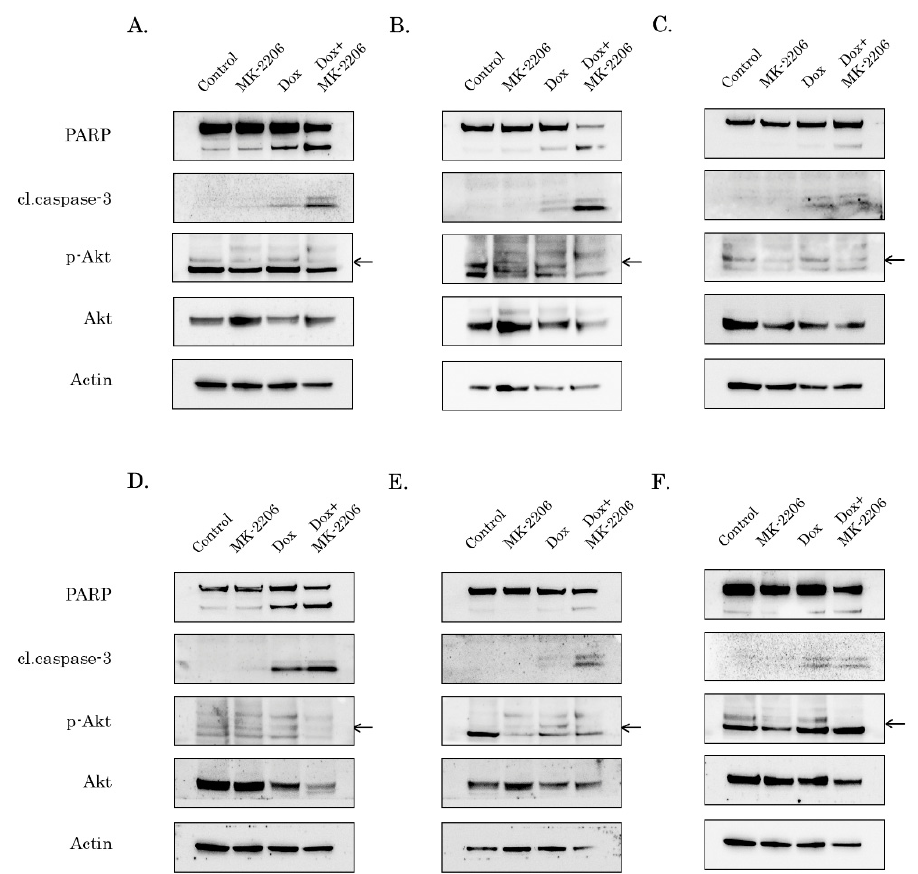
Figure 2. AKT inhibition potentiates pro-apoptotic activity of Dox in STS and GIST. Immunoblot analysis for apoptosis markers (cleaved forms of poly-(ADP)-ribose-polymerase (PARP) and caspase-3) in RD rhabdomyosarcoma ( A ), U2-OS osteosarcoma ( B ), HT-1080 fibrosarcoma ( C ), GIST T-1R ( D ), GIST 430 ( E ) and SK-LMS-1 leiomyosarcoma ( F ) cells after treatment with DMSO (control), Dox (0.25 g / mL) and MK-2206 (5 M) alone and in combination (e.g., Dox + MK-2206) for 72 h. The lysates were also probed for total and phosphorylated forms of AKT to illustrate AKT inhibition by MK-2206. pAKT expression is shown by arrows. Actin was used as a loading